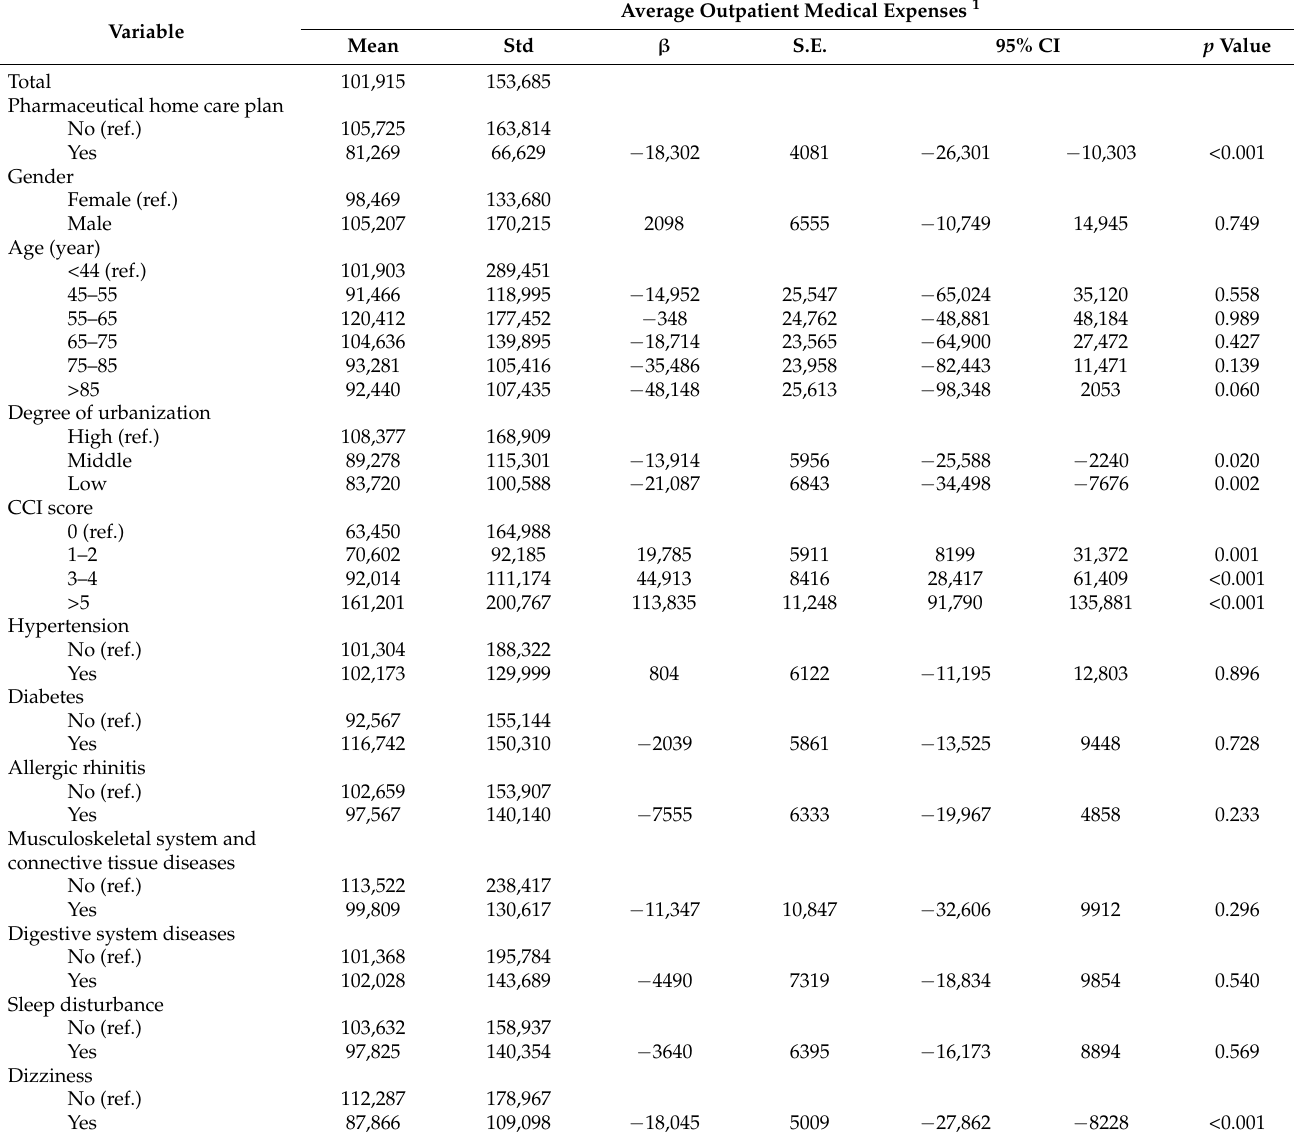
Table 4. The impact of participation in the pharmaceutical home care plan on outpatient medical expenses.